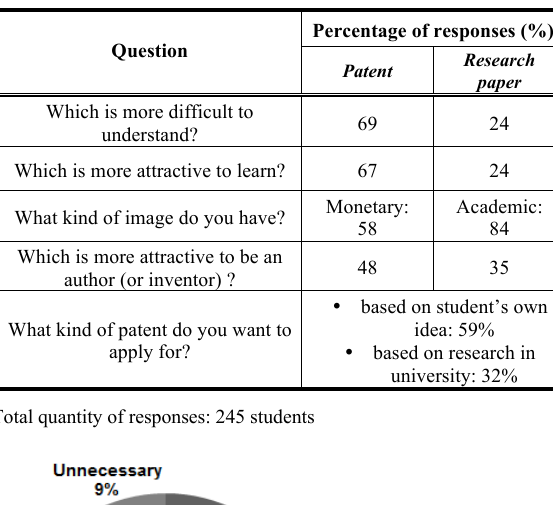
TABLE I. P ERCEPTION OF PATENTS AND RESEARCH PAPERS FROM THE STUDENT ’ S